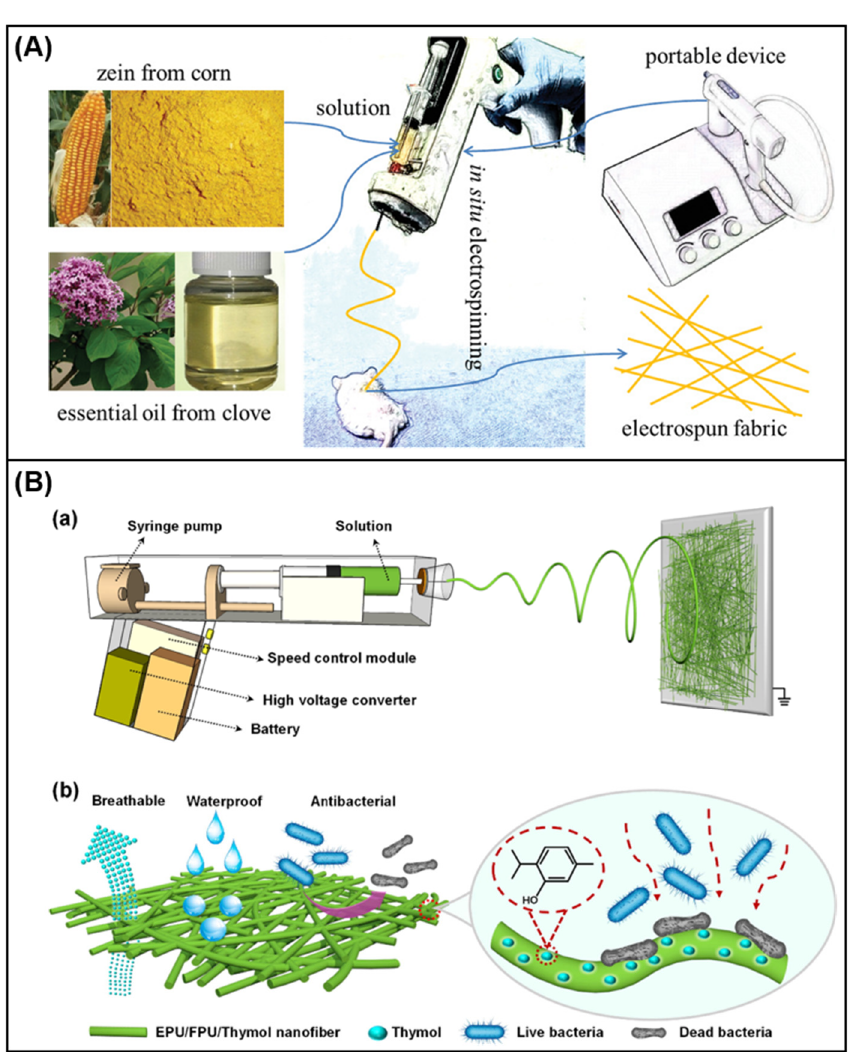
Figure 8. ( A ) In situ electrospinning process [148]; ( B ) [149] ( a ) schematic diagram of portable elec- trospinning device and preparation of EPU/FPU/thymol nanofiber; ( b ) schematic diagram of the breathable, waterproof and antibacterial functions of EPU/FPU/Thymol